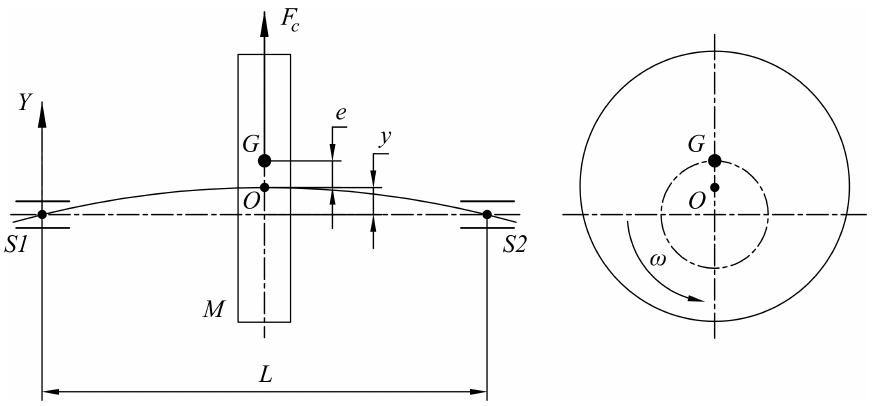
Figure 2. Sketch of an unbalanced